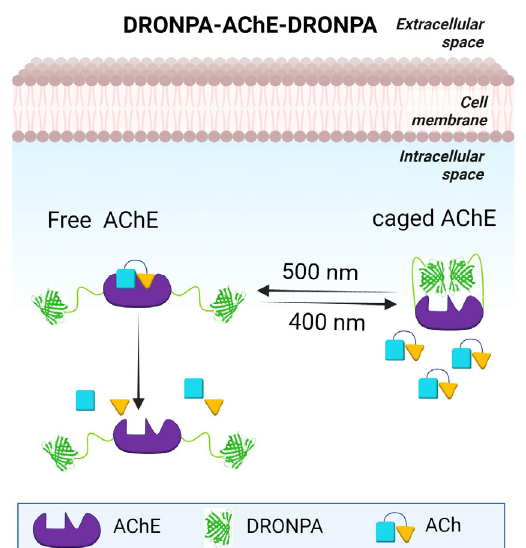
Figure 2. Optogentic control of acetylcholinesterase (AChE). Activity of AChE could be regulated by light with 400 nm light activating DRONPA dimerization blocking the enzyme’s active site. 500 nm light reverses the dimerization allowing AChE to hydrolyse Acetylcholine into acetic acid and cho ‐ line.